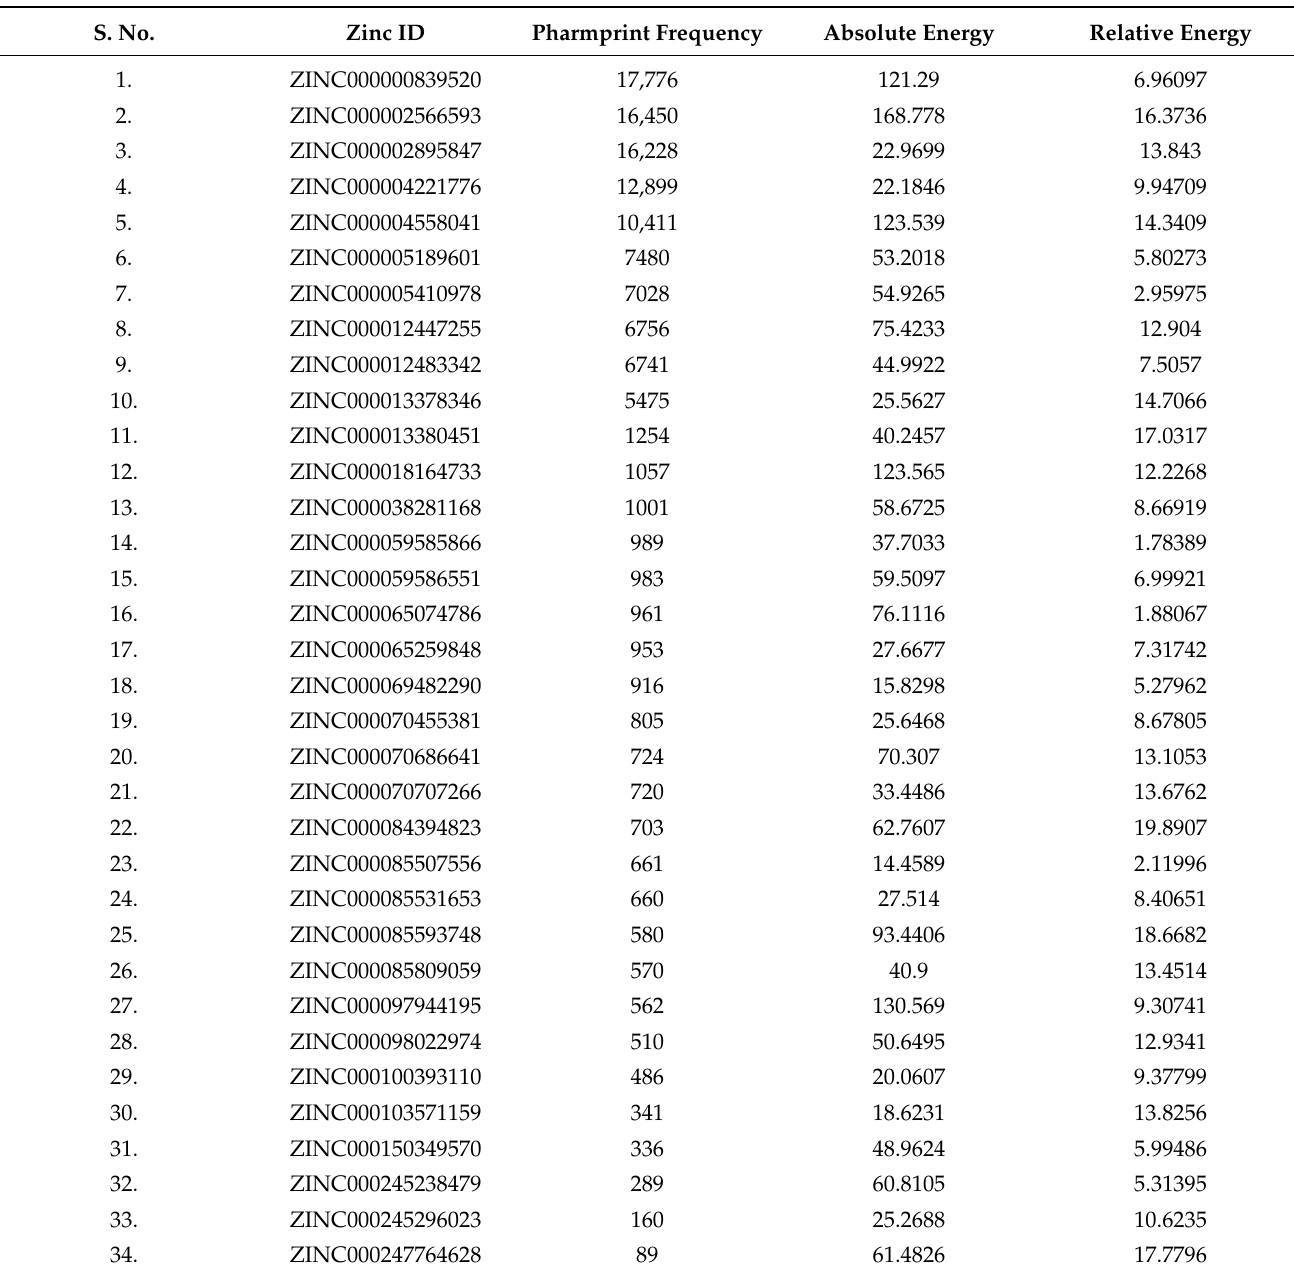
Table 1. Virtually screened compounds from the natural compound database.